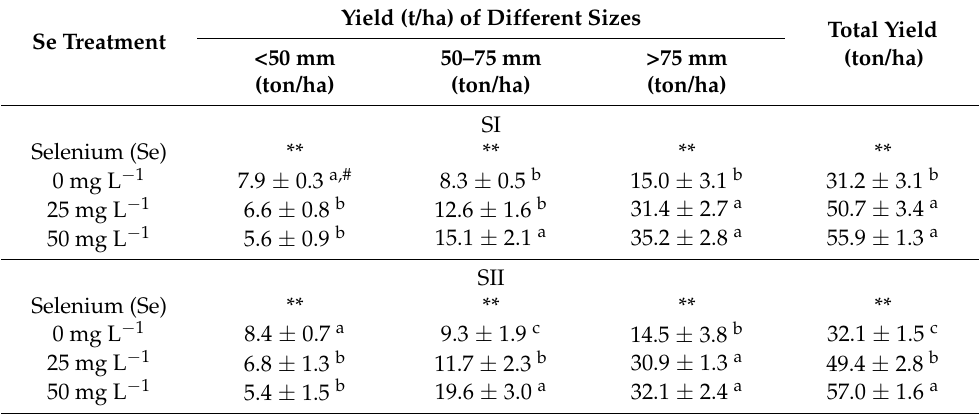
Table 5. Effects of foliar applications with selenium (Se) on yield (t/ha) of different sizes of onion